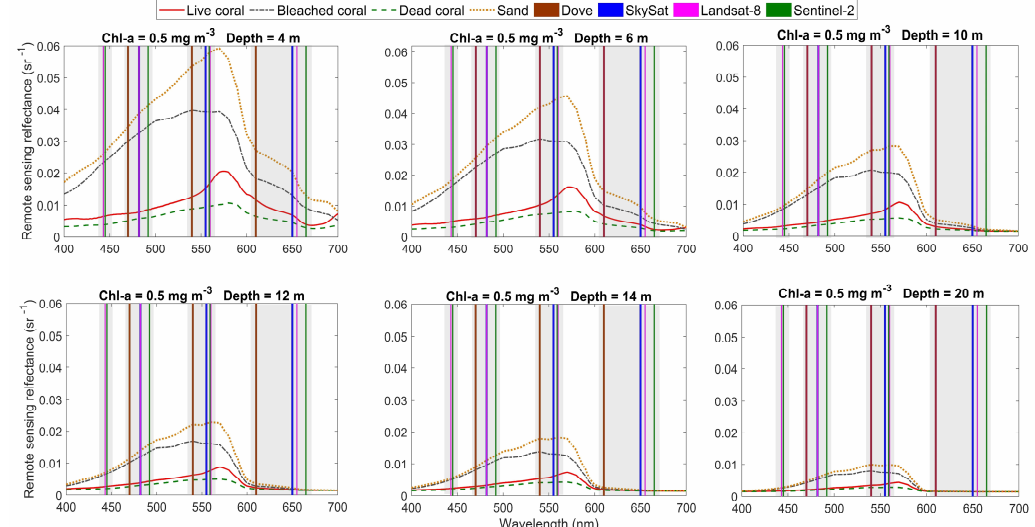
Figure 3. Model-generated remote sensing reflectance at different depths with constant chlorophyll-a concentration.